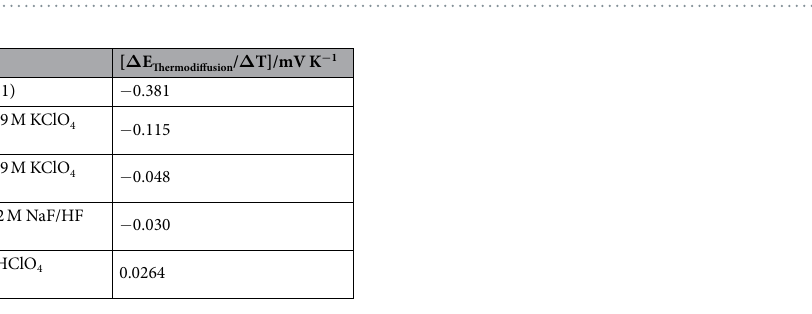
Table 1. Calculated thermodiffusion potentials for the electrolytes employed in this work using the transport numbers calculated from the ionic mobilities at infinite dilution 71